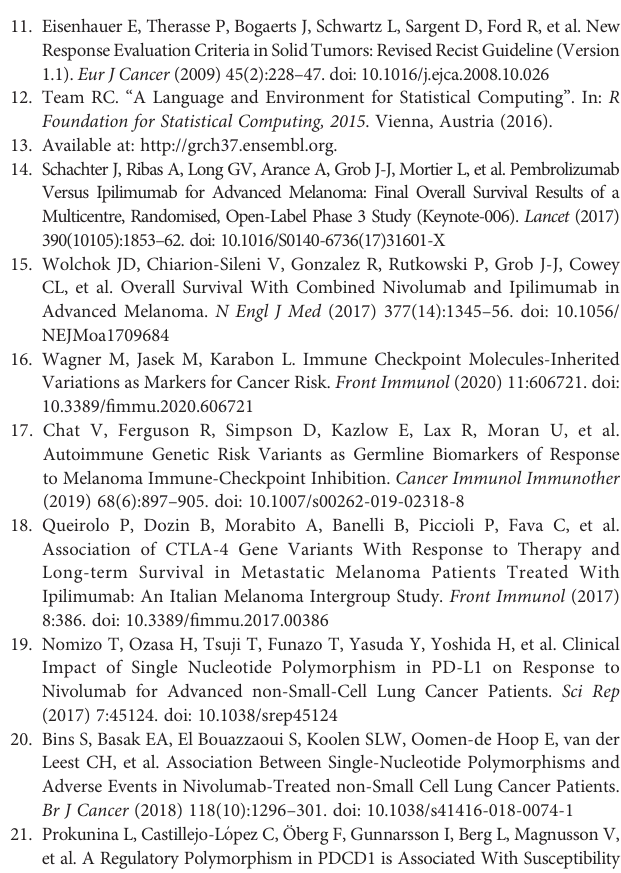
Supplementary Table 1 | Relationship between responses vs genotype. Supplementary Table 2 | Multivariate Cox model for